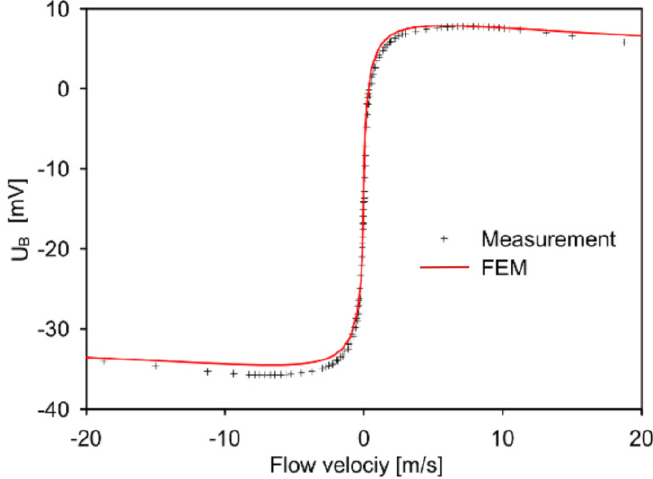
Figure 8. Measured and simulated dependence of U on the mean flow velocity for design 1 at B ambient temperature of 22.2 °C. The main parameters of the measured characteristic, i.e. , the extrema of U appearing at the velocities v and v as well as the slope s of the B peak+ peak− characteristic at zero flow are listed in Table 1. Two flow controllers of 100 cm 3 /min and 2000 cm 3 /min capacity were alternately used to cover the maximum flow